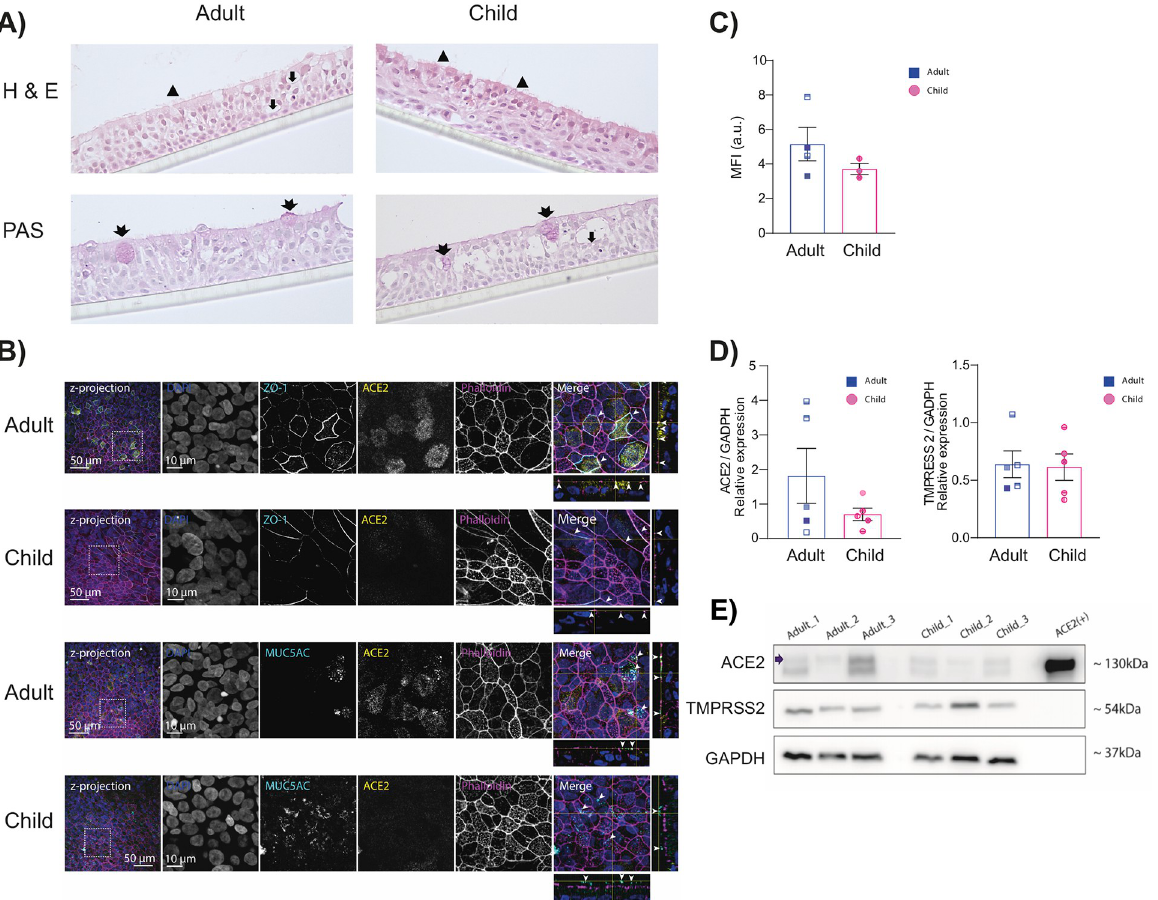
Fig 1 AU : AbbreviationlisthavebeencompiledforthoseusedinFigs 1 (cid:0) 4 ; S 1 (cid:0) S 3 ; S 1 andS 2 Tables : Pleaseverifythatallentriesarecorrect : . Pediatric nasal epithelial cells are phenotypically different to adult nasal epithelial cells. ( A ) Representative HE- and PAS-stained sections of pediatric and adult NECs culture differentiated at an air–liquid interface (representative of 2 adults (1 female, 1 male) and 3 pediatric (1 female, 2 males) donors). Arrowheads indicate ciliated cells, arrows indicate goblet cells, and double-tailed arrows indicate mucus-producing cells as determined by PAS staining. Images taken at 400 × magnification. Each scale bar is equivalent of 150 μ m. ( B ) Representative z-projections (150 optical sections) of pediatric and adult NECs cultures differentiated at an air–liquid interface and immunolabeled against endogenous ZO-1 and ACE2 (cyan and yellow, respectively, top panels) and MUC5AC and ACE2 (cyan and yellow, respectively, bottom panels). Cells were also stained with DAPI (blue) and phalloidin (magenta) to indicate the nucleus and actin filaments, respectively. The area in the dotted box in the images on left are shown magnified in the respective rows (10- μ m bar applies to all images in the row). The merged image on right shows the orthogonal view of the z-stacks. The arrowheads indicate the ZO-1-stained profiles (top panels) and mucus secretion (MUC5AC) in the lower panels. ( C ) Quantification of ACE2 immunofluorescence as described in the Materials and methods. Mean ± SEM is shown. Each data point represents the average of 5 separate images taken from 1 donor (adult ( N = 4, 2 females, 2 male) and pediatric ( N = 3, 2 females, 1 male)). ( D ) Relative ACE2 and TMPRSS2 protein levels compared to GAPDH in adult (3 females, 2 males) and pediatric (3 females, 2 males) NECs. Each data point represents a different donor. Mean ± SEM is shown. (E) Representative western blot of NECs from 3 adult and 3 pediatric donors blotted for ACE2, TMPRSS2, and GAPDH. ACE2 is indicated with an arrow. Each donor is indicated by unique symbol that is used consistently throughout all figures. Data are contained in S1 Data, and raw western blot images are available in S1 Raw images. ACE2, angiotensin-converting enzyme 2; GAPDH, glyceraldehyde 3-phosphate dehydrogenase; HE, hematoxylin–eosin; NEC, nasal epithelial cell; PAS, periodic acid–Schiff;